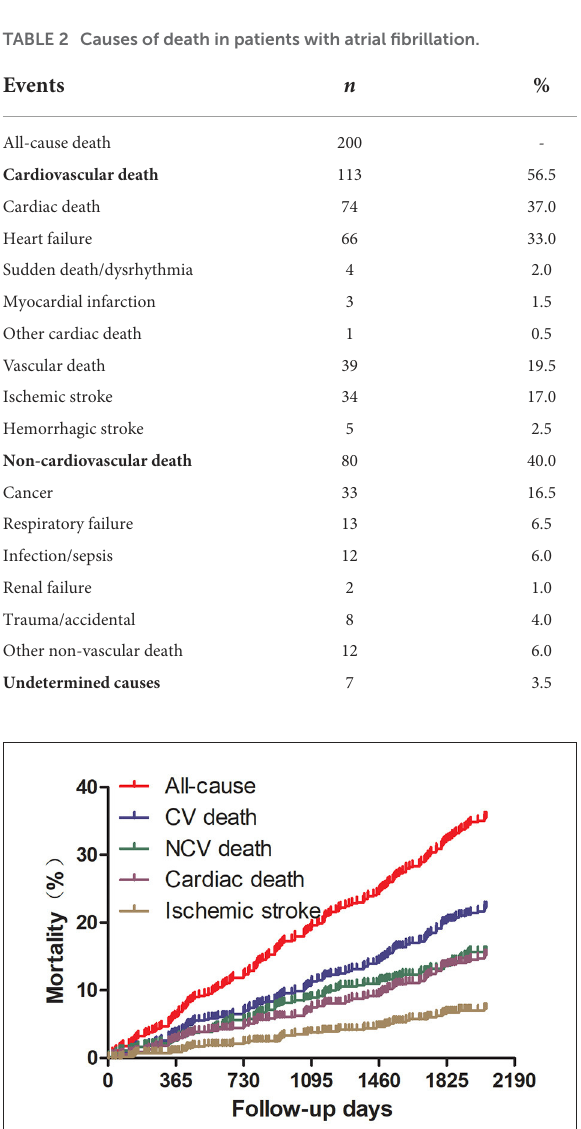
to be independently associated with non-cardiovascular death